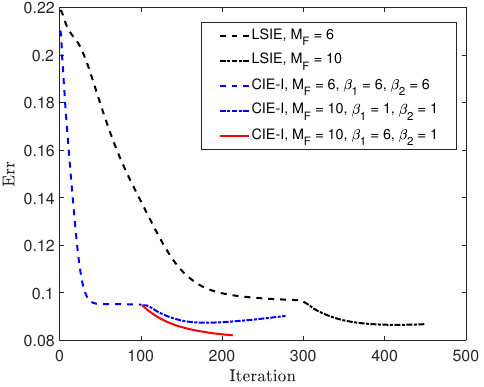
Figure 6. Errors of reconstructions obtained by different inversion methods for Example 1 .